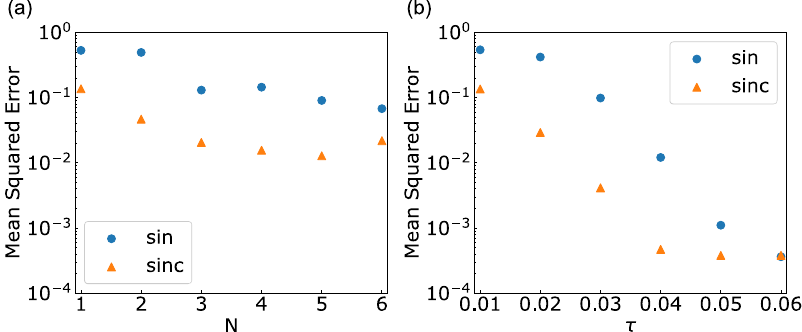
Fig. 3 Mean squared error of the trained models for the regression task of sine and sinc functions. a , b shows results for experimental NMR kernel and numerically simulated kernel,